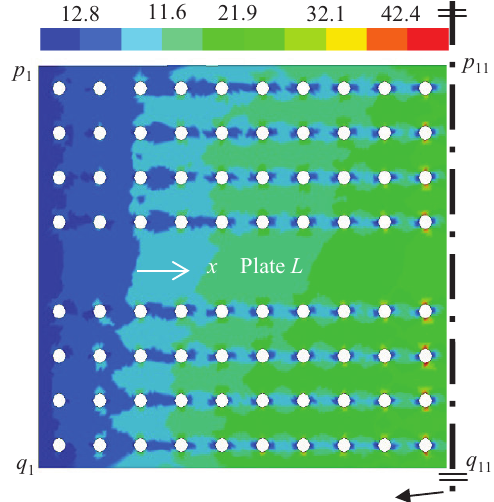
Figure 11. The -stress in the splice plate L